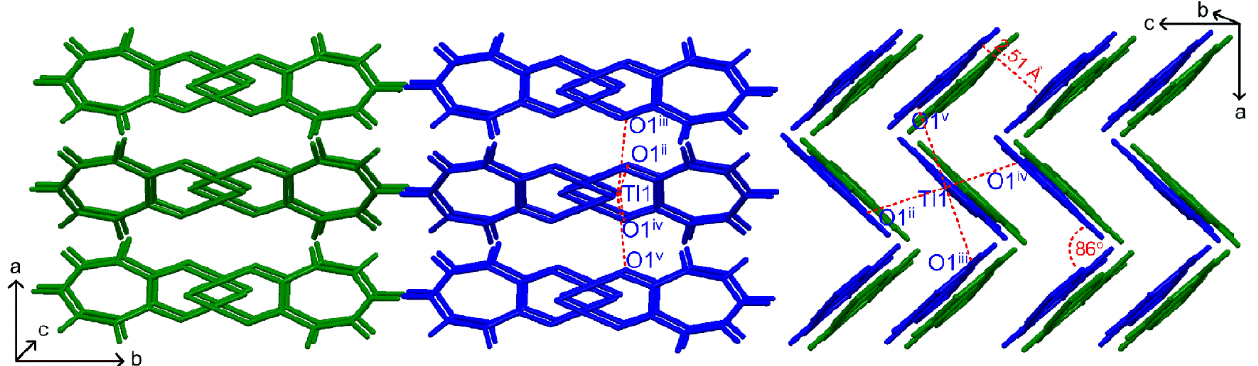
Figure 5. Two different views of the arrangement of Tl(trop) chelates in the extended structure of 1 showing the chosen intermolecular Tl···O contacts.